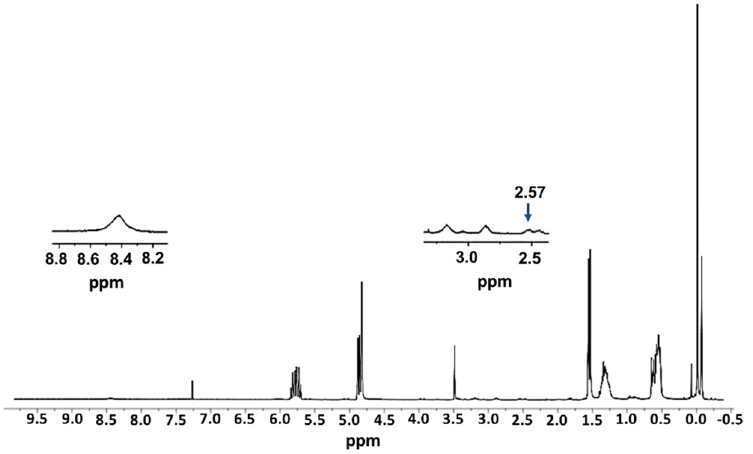
Figure 2. 1 H-NMR of G 3 Si(Allyl) 31 (SC 2 H 4 NH 3 Cl) (I) in CDCl 3 .